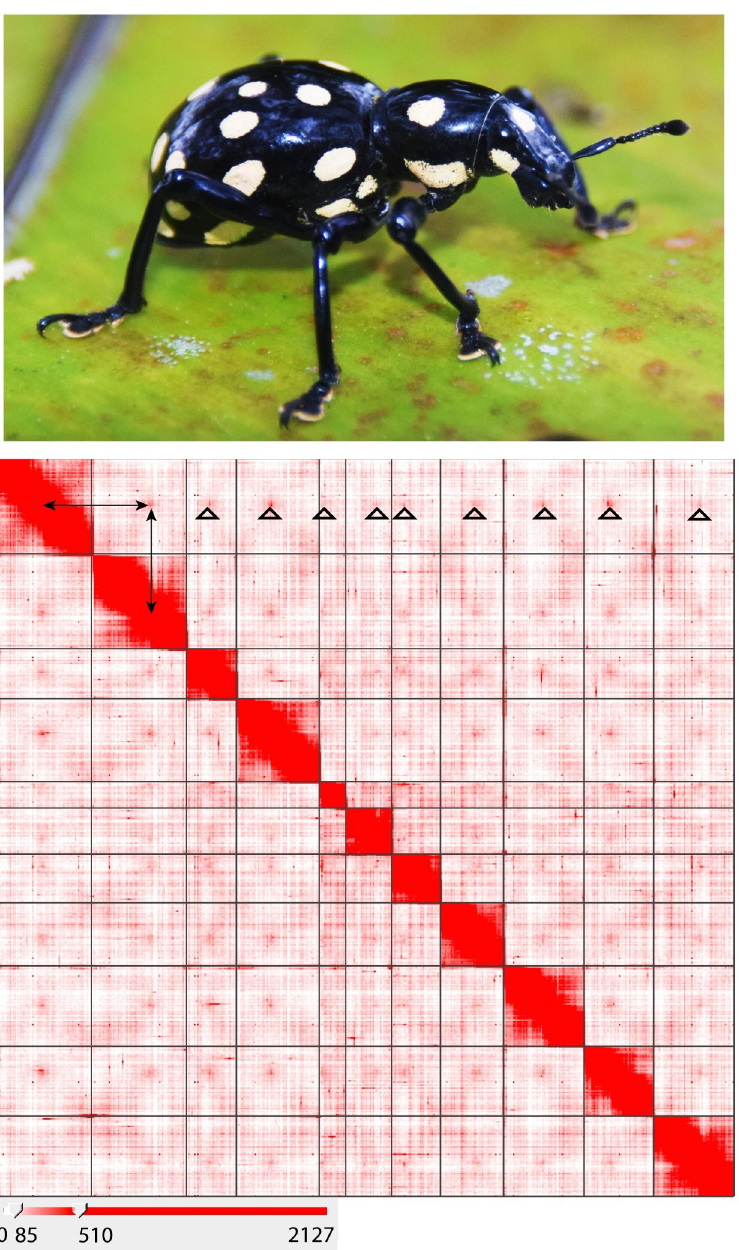
Fig 1. Pachyrhynchus sulphureomaculatus , lateral habitus. (photo by A. Cabras). Hi-C contact map heatmap of Pachyrhynchus sulphureomaculatus Schultze, 1922. Eleven chromosome boundaries are indicated by black lines. Heatmap scale lower left, range in counts of mapped Hi-C reads per megabase squared. Rabl-like pattern (grouping of telomeres and centromeres to the nuclear envelope) highlighted along chromosome 1, top row, top of open triangles point to contact between centromere regions, arrows indicate centromere to centromere contact between chromosomes 1 and 2. X-like pattern between adjacent off diagonal regions indicative of contact between distal portions of chromosomes. version 4 and 5-beta), the percentage of complete genes varied (90.8% V2 (S2 Fig)), indicating a relatively complete assembly. Compared to other chromosome-level beetle genomes, we found a comparable number of complete BUSCO genes. However, the results vary somewhat